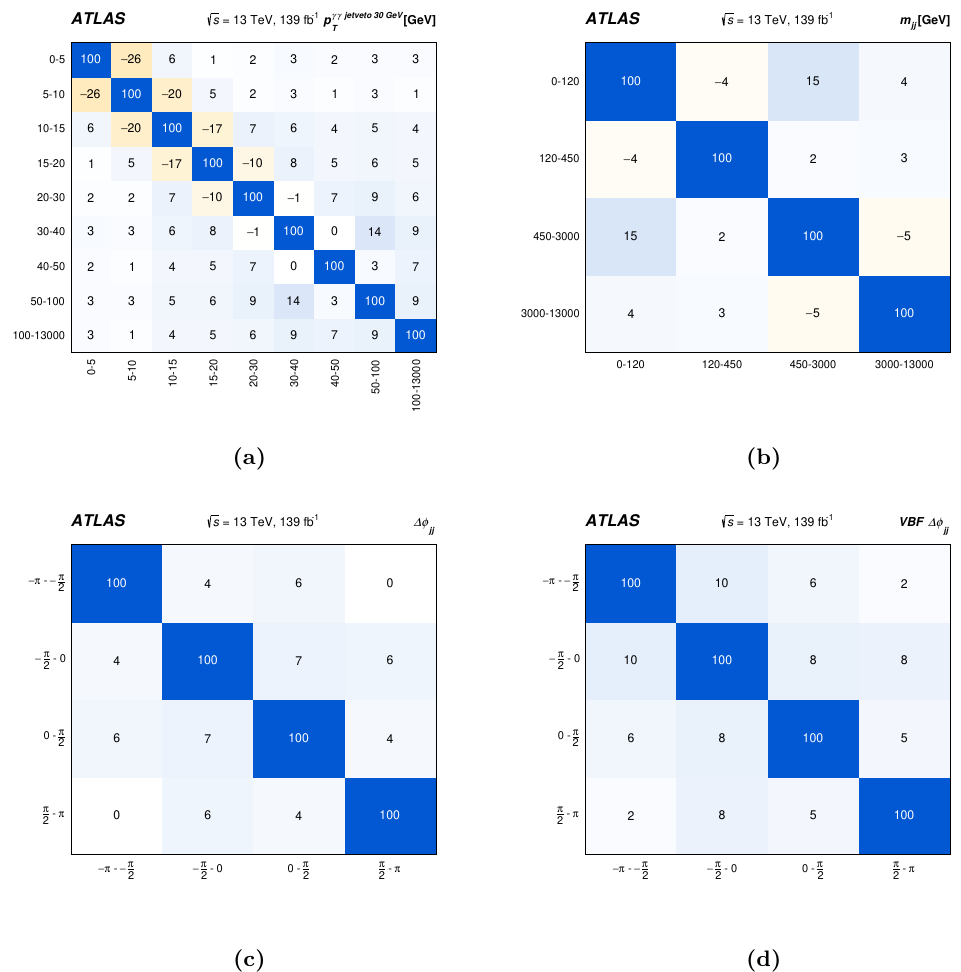
with a 30 GeV T